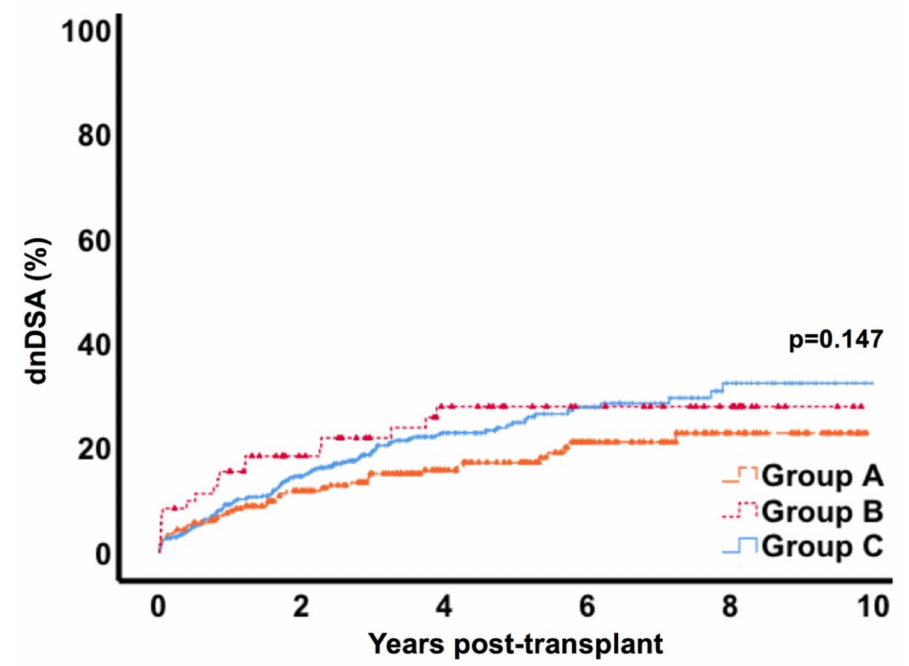
Figure3. Formationofdonor-specificantibodiespost-transplant. *GroupA = lymphoceleconservatively monitored; Group B = lymphocele with intervention; Group C =